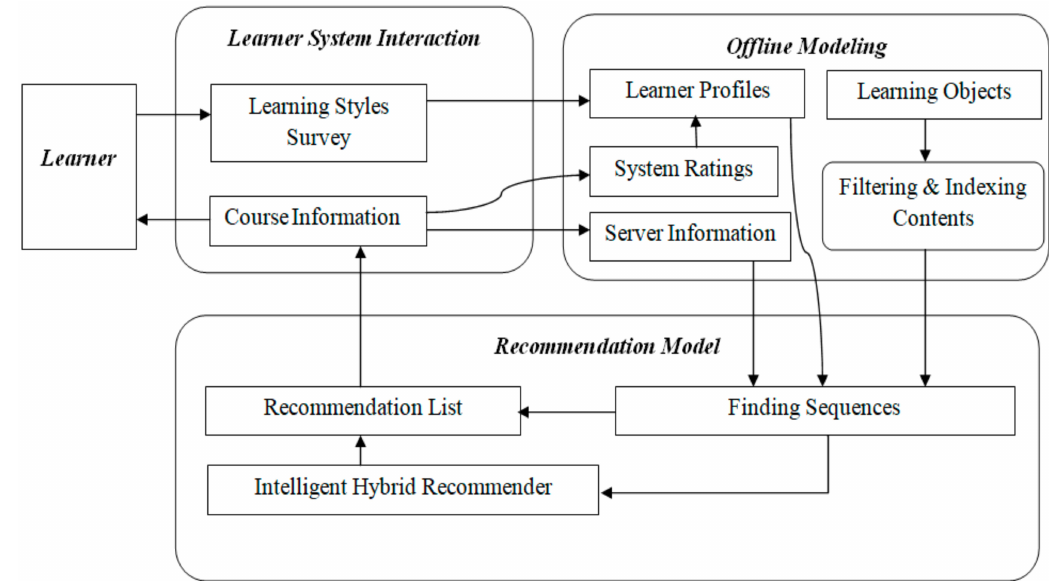
Figure 2. The recommendation component architecture of the proposed